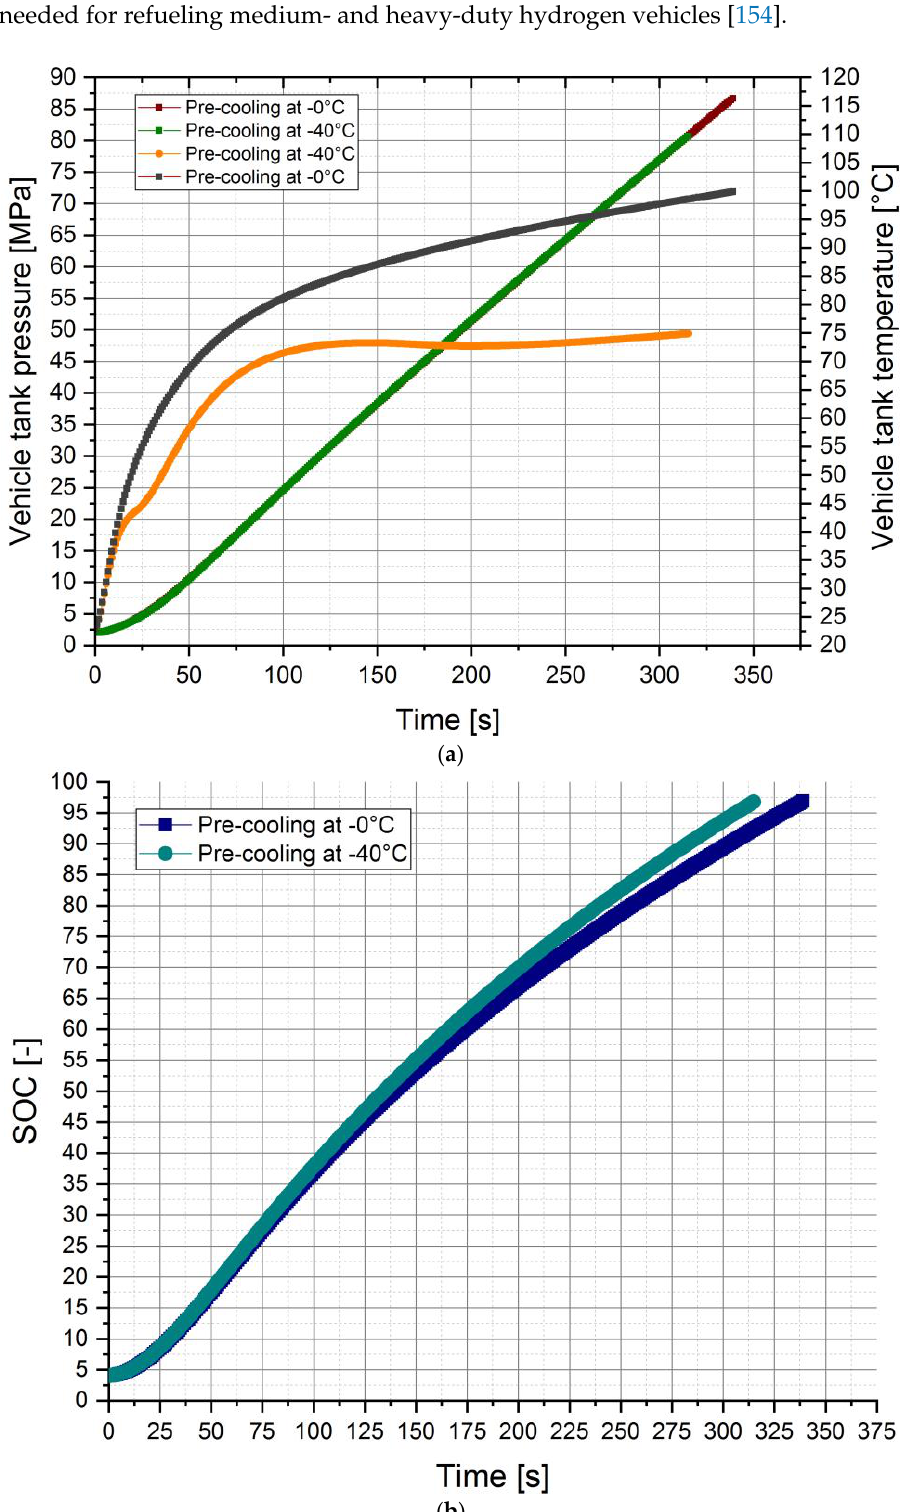
Figure 14. Pressure and temperature profiles ( a ), and SOC profile ( b ), for a refueling process with imposed APRR, calculated via the adoption of the H2Fills Tool [137].